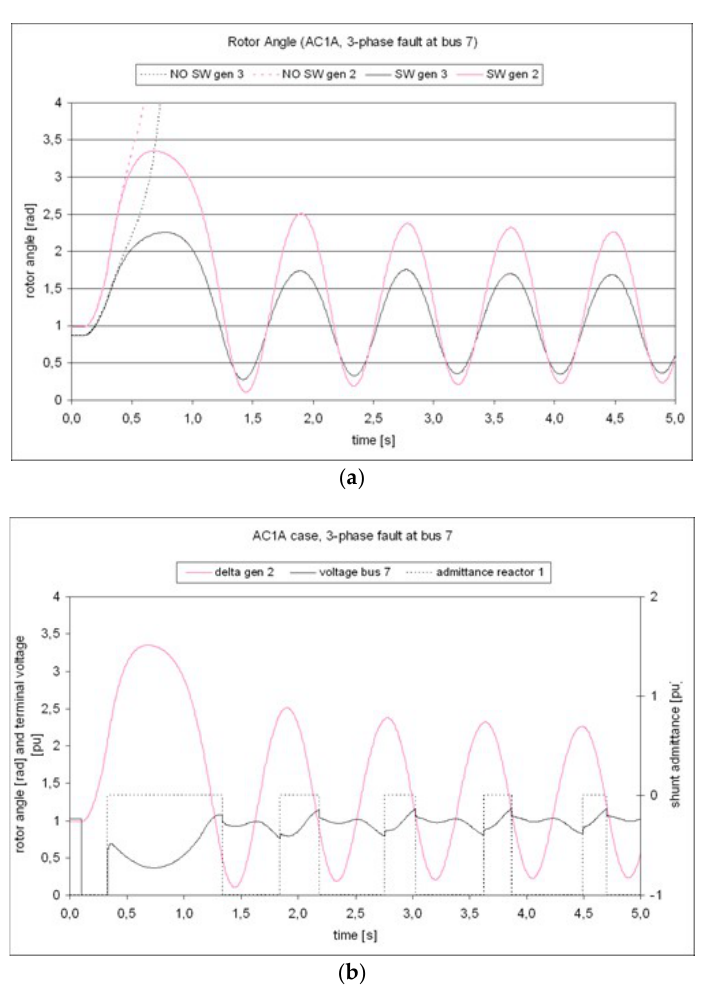
Figure 5. Simulation results of IEEE test system with AC1A exciter: ( a ) Rotor angles of generators G2 and G3 (relatives to generator G1) for a three phase fault on bus 7, with and without shunt reactors switching; ( b ) Rotor angle of generator G2 (relative to generator G1), voltage of bus 7, shunt admittance of the first reactor, for a three phase fault on bus 7, with reactors switching.